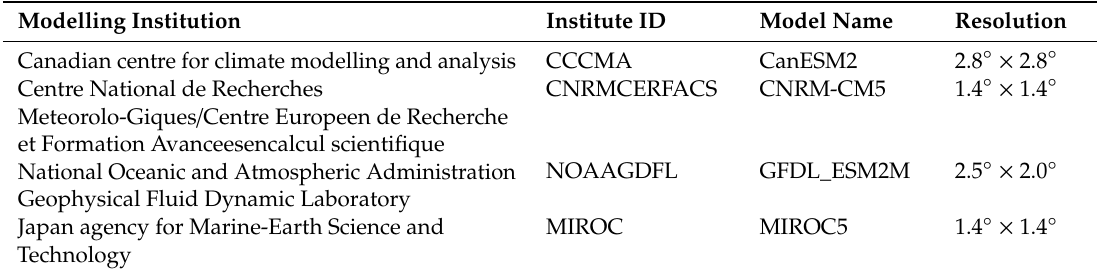
Table 1. List of statistically downscaled and bias-corrected GCMs used in the